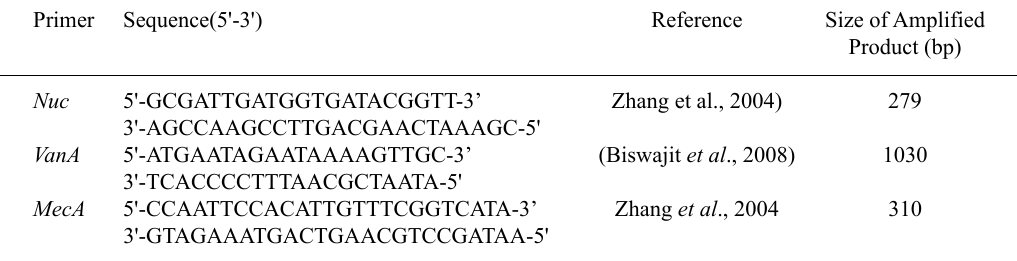
table 2. Distribution of 200 Neonates with suspected sepsis